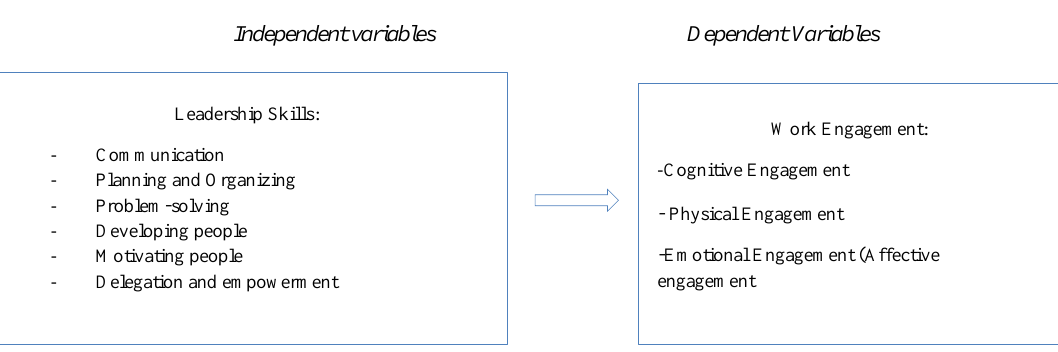
Figure 1: The conceptual framework reflects the independent and dependent variables; Source: Foronda, 2010; Kuok and Taormina, 2017; Abun,